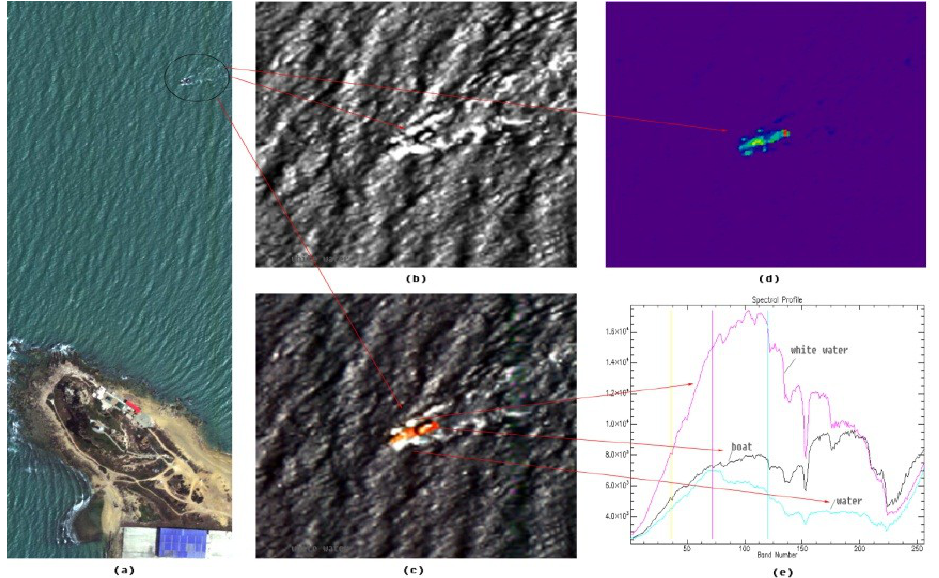
Figure 16. Hypers-pectral image of a port ((a) shows the RGB image of the coast, (b) and (c) show the images at two different spectral channels, (d) distinguishes the boat from the background using characteristic bands, and (e) shows the spectral curves of white water, boat and dark water).